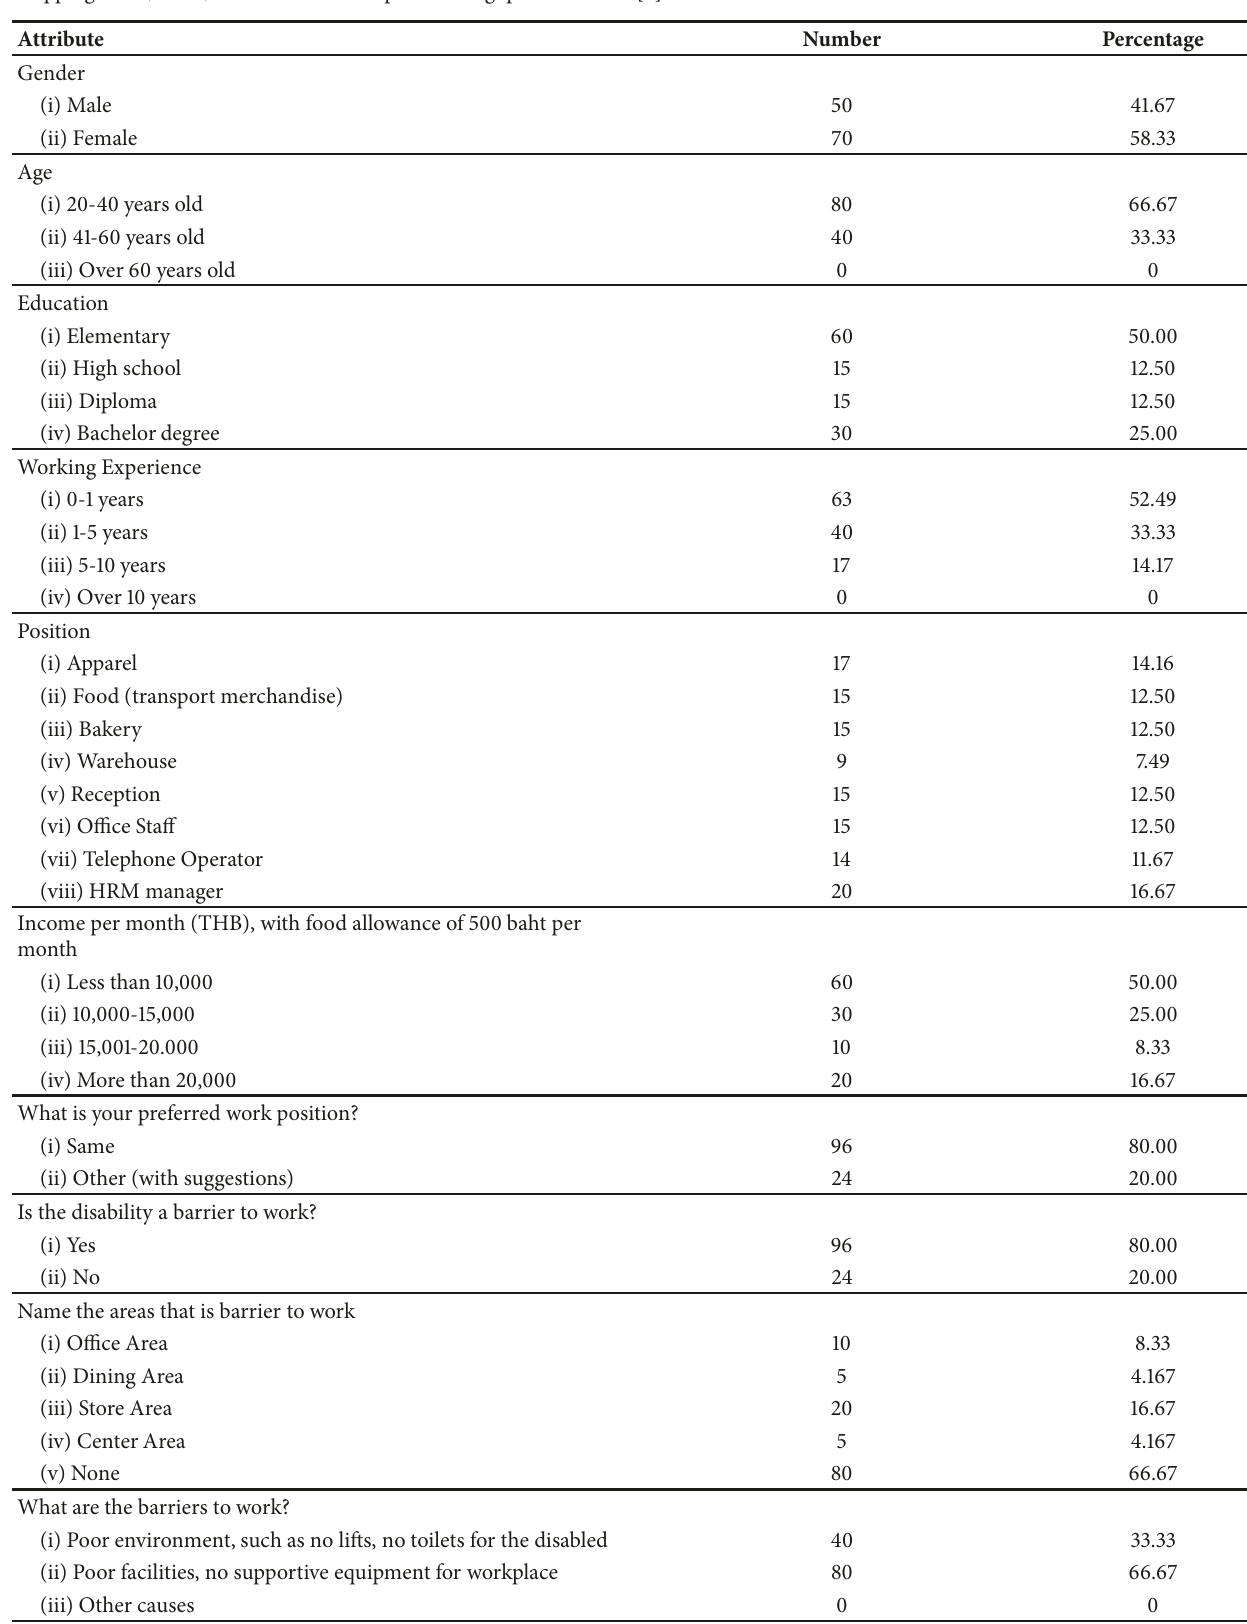
Table 1: Study and development of a workplace environment for people with disabilities, consulting trainers of 120 people employed at shopping malls, retail, and wholesale companies using questionnaires